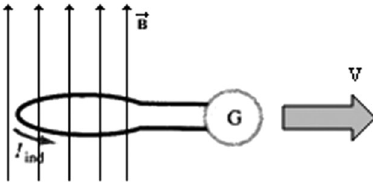
generator.FIG. 9. The coil is coming out of a stationary magnetic